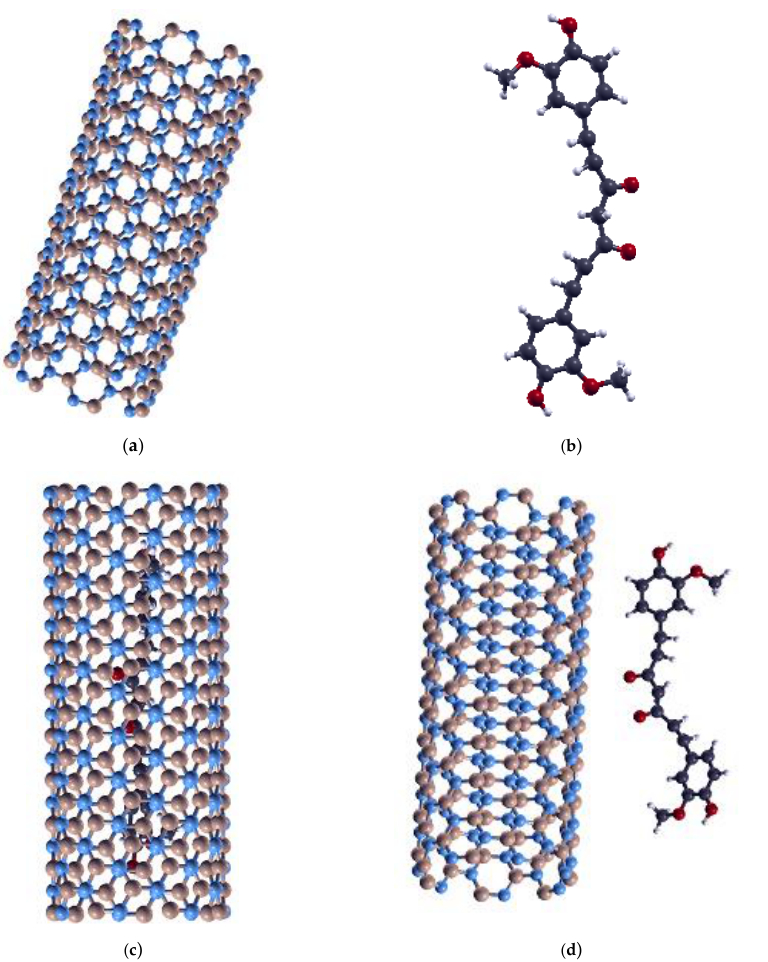
Figure 1. The optimized structure of ( a ) (5,5) BNNT, ( b ) curcumin drugs and their adsorption, ( c ) inside and ( d ) outside the BNNT.